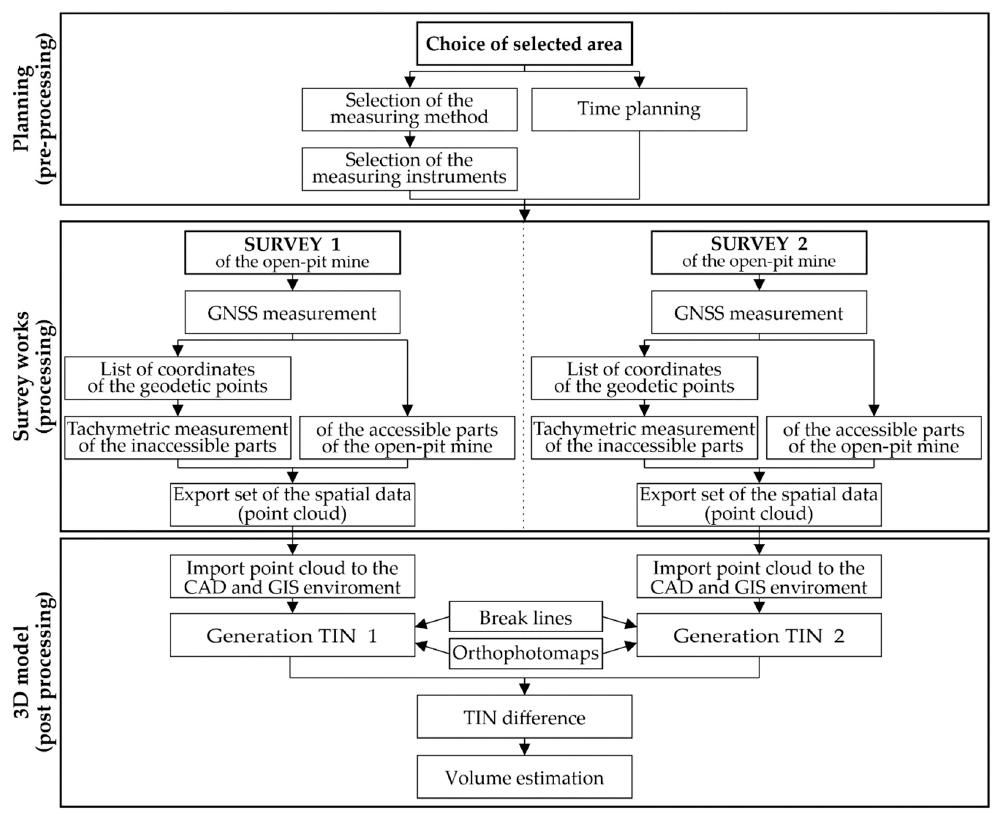
Figure 5. Workflow for the creation of the 3D model in the study area.